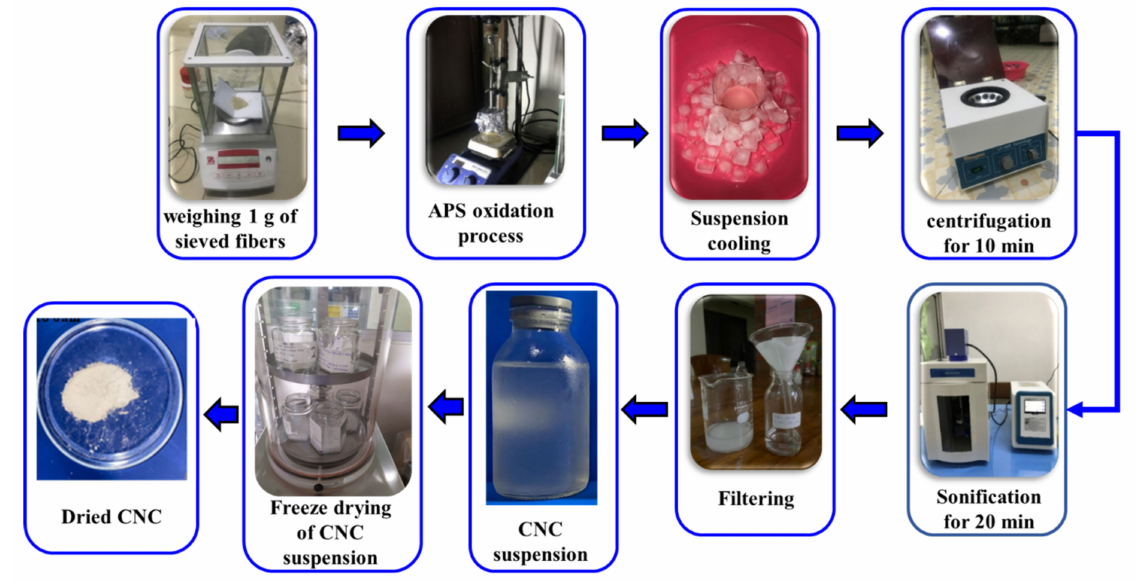
Figure 2. Isolation of CNCs from STFs via APS oxidation